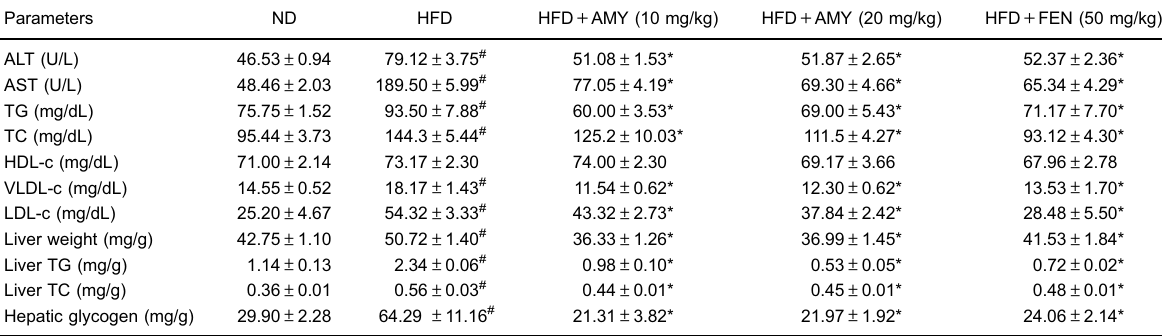
Figure 2. a , b -Amyrin (AMY) improved glucose tolerance and insulin resistance in HFD-fed mice. A , serum glucose level in glucose tolerance test (GTT); B , glucose area under the curve (AUC) during GTT; C , serum glucose in insulin tolerance test (ITT); D , glucose area under the curve (AUC) during ITT. Data are reported as means ± SE (n=8). # P o 0.05 vs ND-fed animals; *P o 0.05 vs HFD-fed animals (ANOVA followed by the Student - Newman - Keuls test or two-way ANOVA followed by the Bonferroni ’ s test). ND: normal diet; HFD: high-fat diet; FEN: feno fi brate. Table 3. Effect of a , b -amyrin (AMY) and feno fi brate (FEN) treatments on serum and liver parameters in mice fed on high-fat diet (HFD) or normal diet (ND) for 15 weeks.